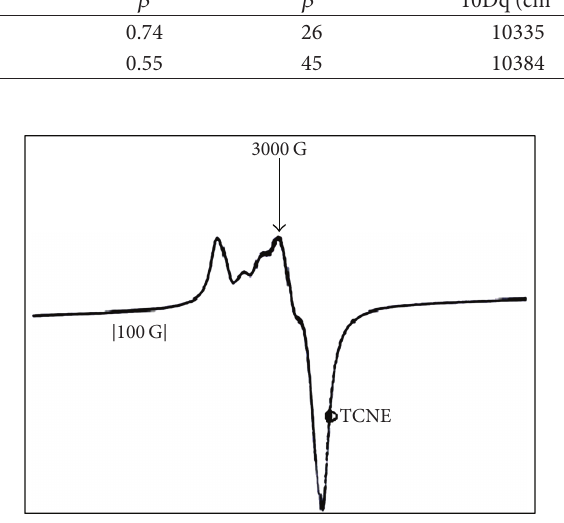
F 5: EPR spectrum of [Cu(CDTMP)